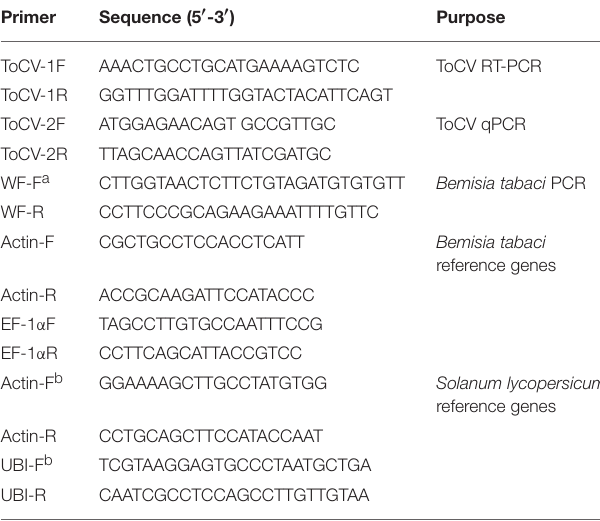
TABLE 1 | Primers used in this